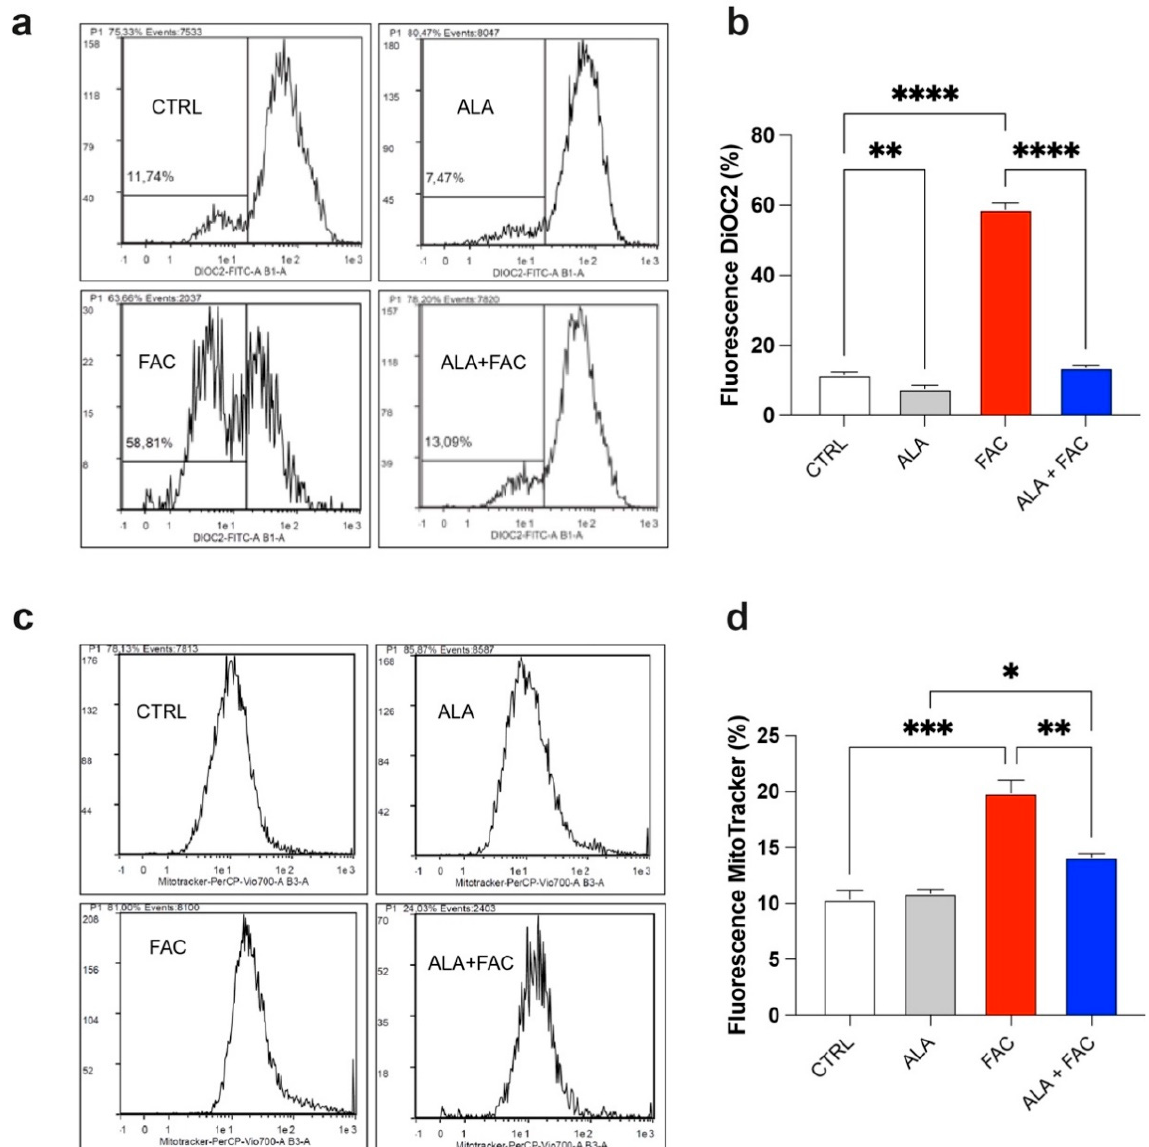
Figure 2. Iron overload increases mitochondrial mass in HMC3 cell line. ( a , b ) Representative plots ( a ) and quantification ( b ) of DiOC2 fluorescence intensity via cytofluorimetric analysis in control, ALA-, FAC- and ALA + FAC-treated HMC3 cells; ( c , d ) Representative plots ( c ) and quantification ( d ) of mitotracker fluorescence intensity via cytofluorimetric analysis in control, ALA-, FAC- and ALA + FAC-treated HMC3 cells. * p -value < 0.05; ** p -value < 0.01; *** p -value < 0.001; **** p -value <